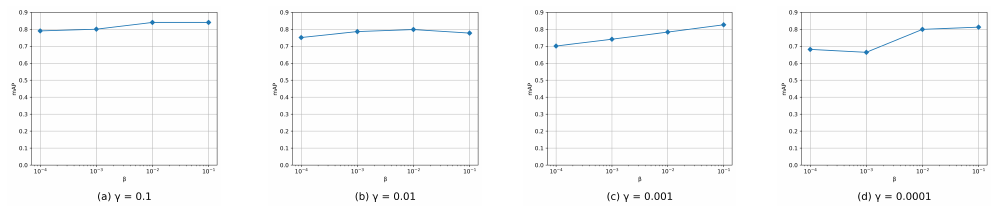
Figure 6. Parameter sensitivity analysis on CIFAR-10 dataset with 48-bit of the proposed